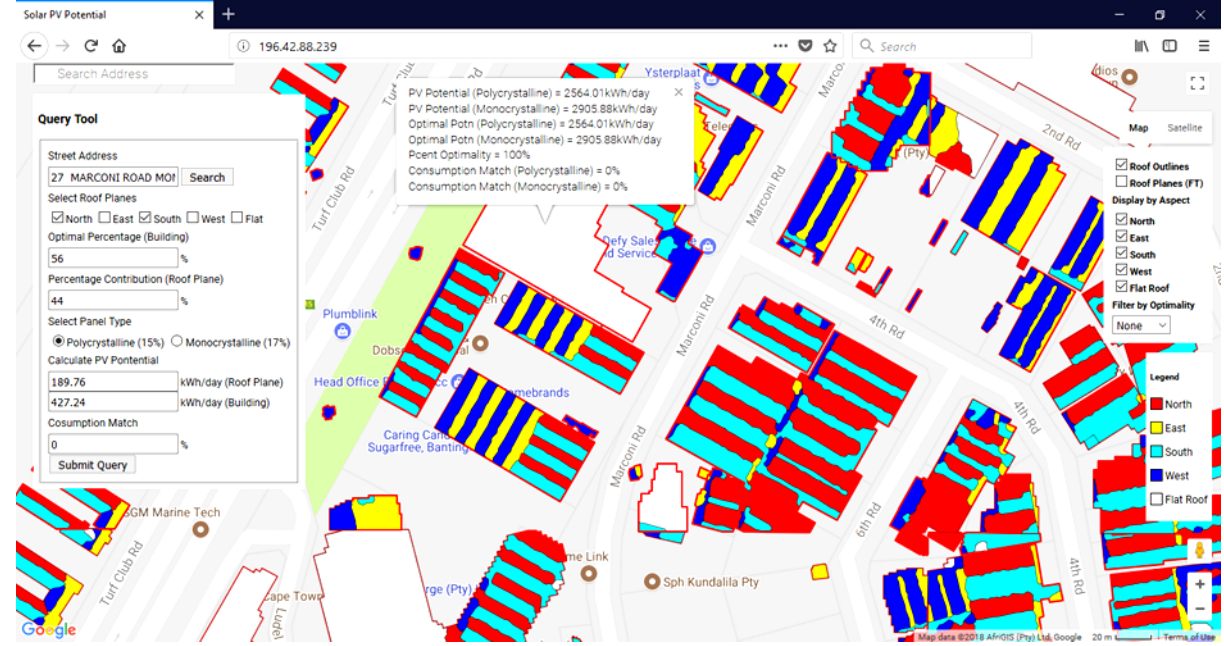
Figure 6. Screenshot 2 of the prototype web-based